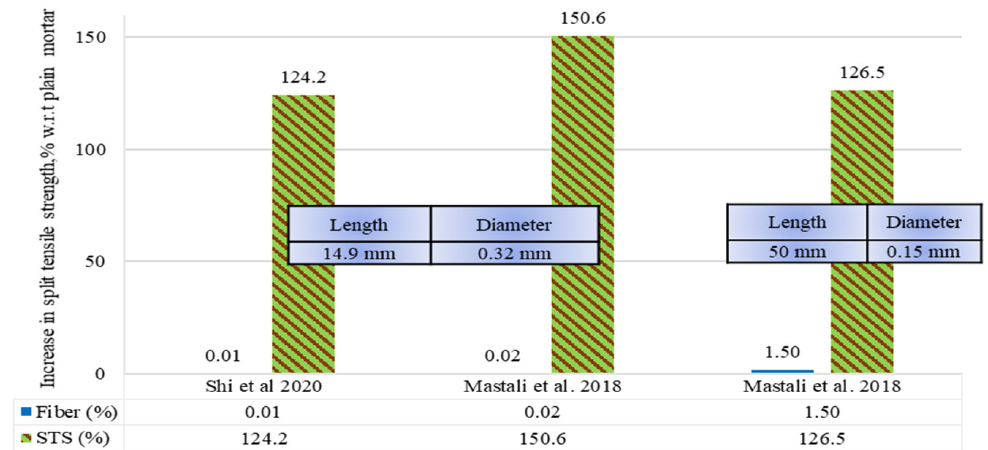
Figure 17. Percentage comparison of split tensile strengths of RSF mortars containing RSF by its volume fraction.